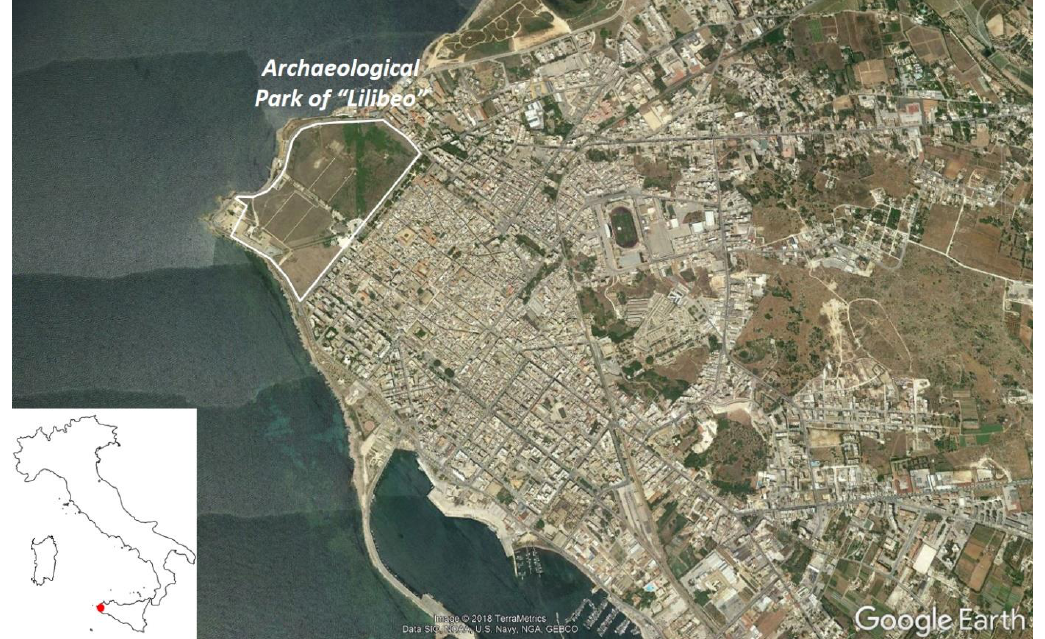
Figure 1. Archaeological Park of “Lilibeo” inside the modern city of Marsala (Italy) (from Google Earth© ). The urban ancient city plan was divided by primary ( plateiai ) and secondary streets ( stenopoi ) organized along an orthogonal grid. The length of the blocks is not yet known, but they measured about 30 m on the short side, as found in the northeast sector of the city where three blocks were excavated ( insulae I – III ). Luxurious homes, with private baths, occupied blocks I – II in Roman times. At the same time, insula III was occupied by a sanctuary dedicated to the goddess Isis.